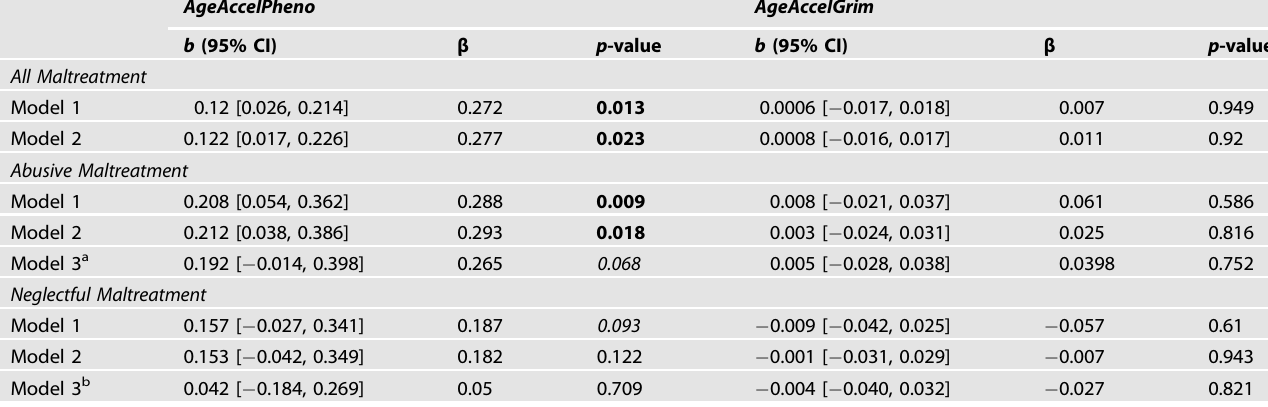
Table 2. Associations of Maltreatment (CTQ) with biological